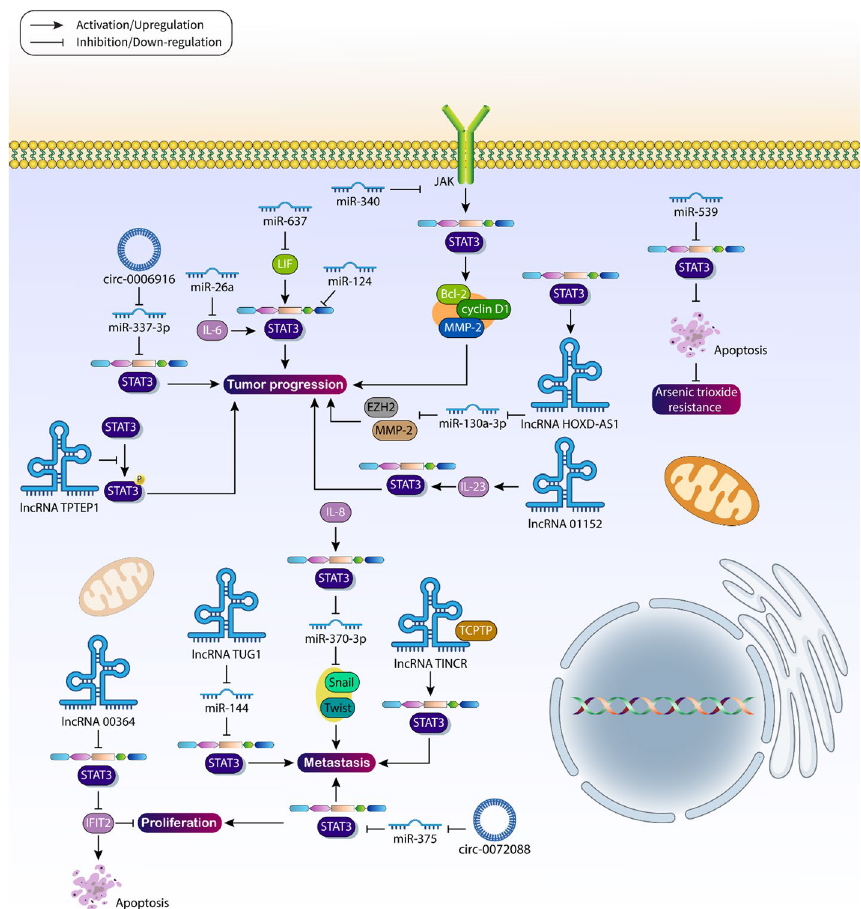
Fig. 5 Regulation of STAT3 signaling by noncoding RNAs in